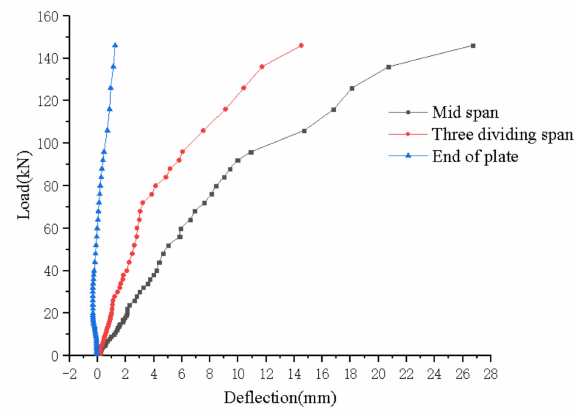
Figure 10. Load-deflection curve of composite